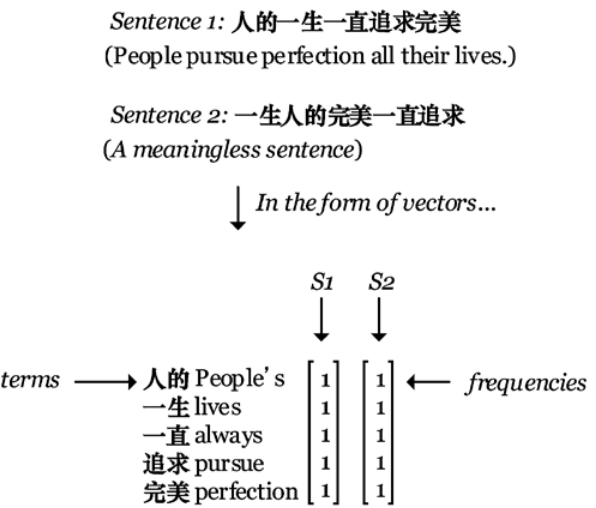
) Shares the Same Occurrence Information (Vectors S 2